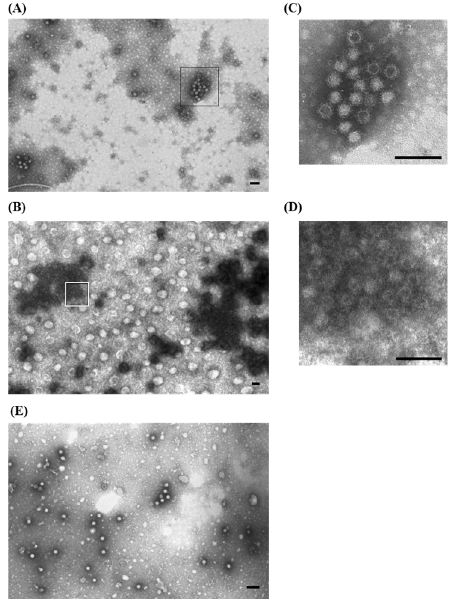
Figure 9. Electron micrograph of ultracentrifuged liver homogenate from European Brown Hare Syndrome (EBHS)-affected hares. Immuno-aggregation electron microscopy preparation with: ( A ) anti-Rabbit Hemorrhagic Disease (RHD) RHDV convalescent sera diluted 1:20; ( B ) anti-EBHSV homologous convalescent hare sera diluted 1:50; ( C , D ); enlargement of insets, showing the typical morphology of calicivirus particles. The size of aggregates, containing both empty and full particles, and the width of the antibody halo depend on the specificity of the convalescent sera used. Smaller and thinner halos were seen using the heterologous rabbit sera, and larger and thicker halos were seen using the convalescent hare sera; ( E ) IAEM negative control of EBHSV positive hare liver. Negative staining (2% sodium phosphotungstate). TEM Philips CM10, 80 kV. Bar = 100